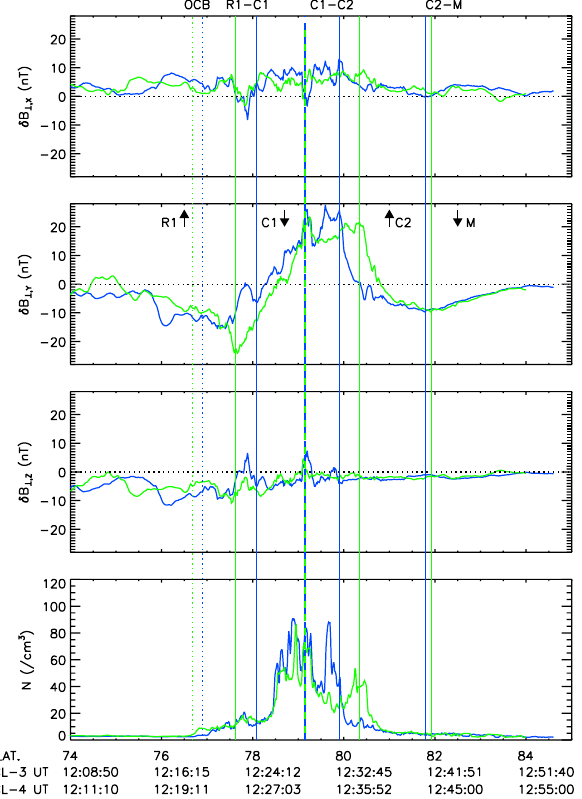
Fig. 5. The three components (GSM) of the perpendicular pertur- bation magnetic field and electron number density observed from Cluster 3 (blue lines) and Cluster 4 (green lines). The vertical dot- ted lines identifies the OCB, the vertical green and blue lines iden- tify the current sheet boundaries. The arrows denote the direction of current flow (see text for